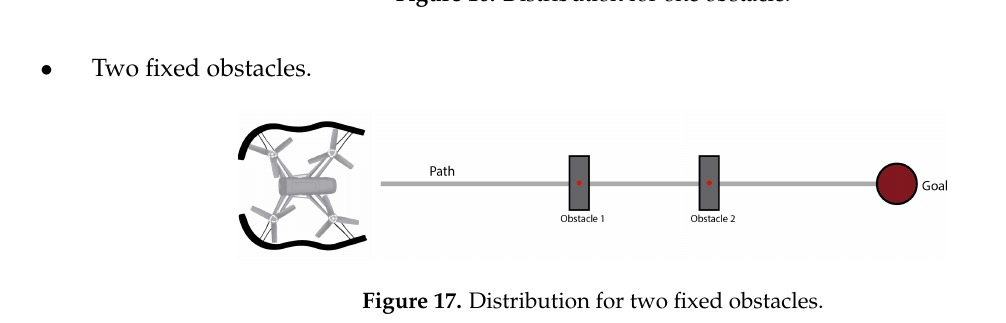
Figure 16. Distribution for one obstacle.